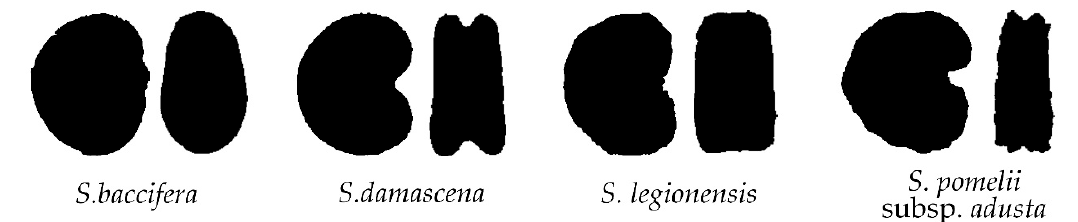
Figure A2. Average silhouettes for the lateral and dorsal views of species in the smooth group.